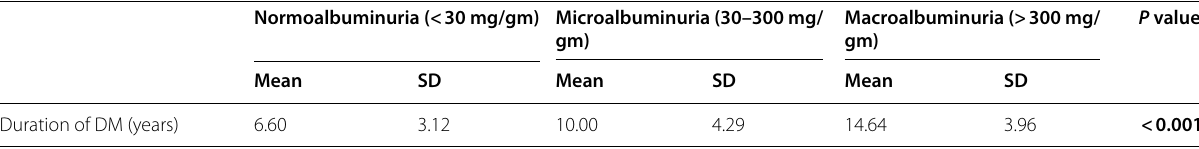
Table 4 Comparison between patient groups regarding the duration of